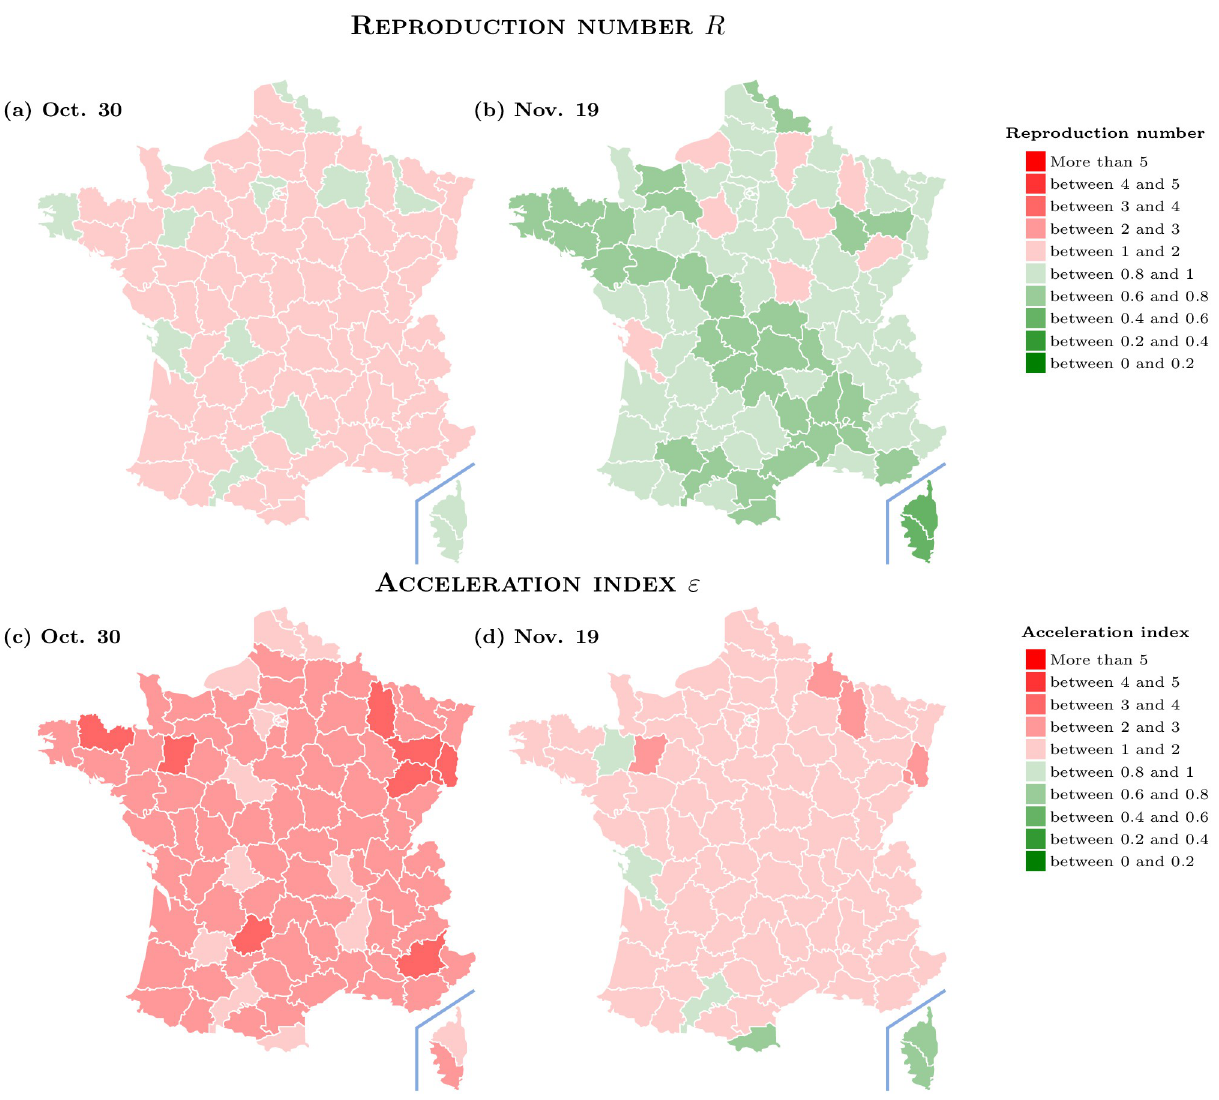
Fig 4. Acceleration index and reproduction number for French de´partements at different dates. October 30 dates the start of the second lock-down in France. Data source: Agence Sante´ Publique France and authors’ computations. (a) Oct. 30, (b) Nov. 19, (c) Oct. 30, and (d) Nov. 19.